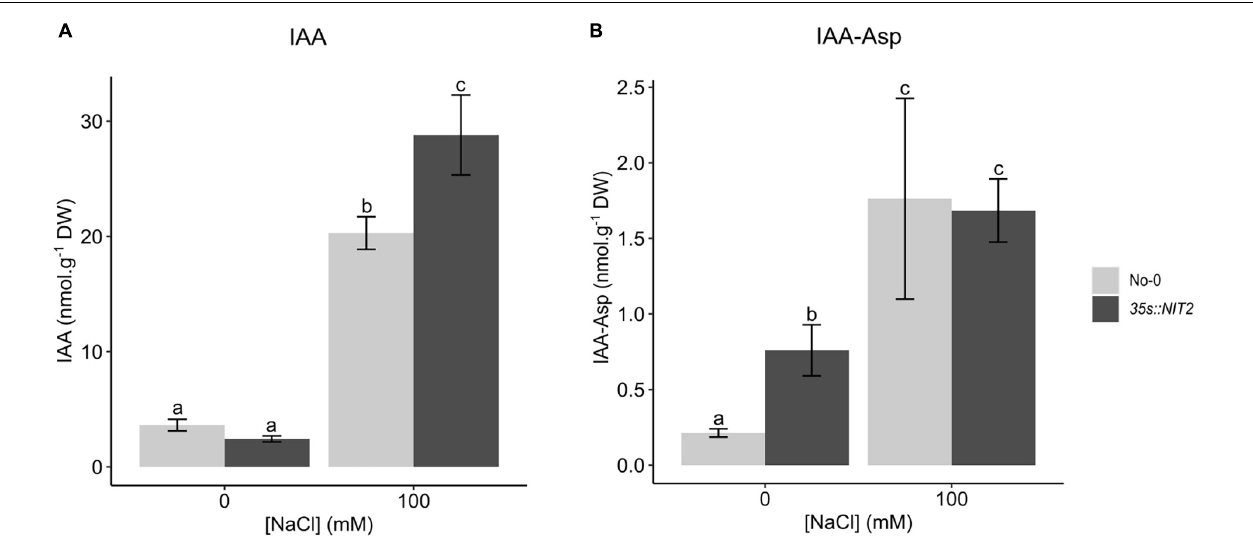
FIGURE 6 | Quantification of IAA and IAA-Asp in No-0 and 35s:NIT2 plants grown on NaCl. No-0 (wildtype) and 35s:NIT2 were germinated and grown for two weeks in petri dishes containing ATS media (0 mM, untreated control) and ATS supplemented with 100 mM NaCl. IAA ( A ) and IAA-Asp ( B ) were quantified by LC-MS/MS. The light gray bars represent No-0 and dark gray bars represent 35s:NIT2 . The results are the mean of five biological repeats. Error bars represent standard error. Different letters on the graph indicate statistically significant differences ( p ≤ 0.05) in metabolite concentration (nmol.g − 1 DW) as determined by one way ANOVA followed by Fisher LSD post hoc